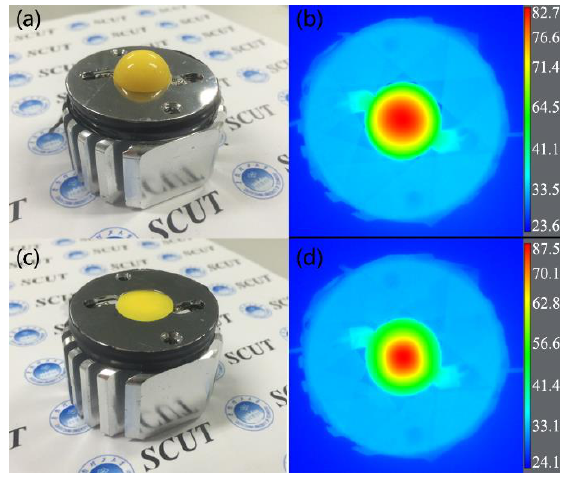
Figure 5. ( a ) Photograph and ( b ) infrared thermal imaging of the sphere-COB; ( c ) photograph and ( d ) infrared thermal imaging of the planar-COB.